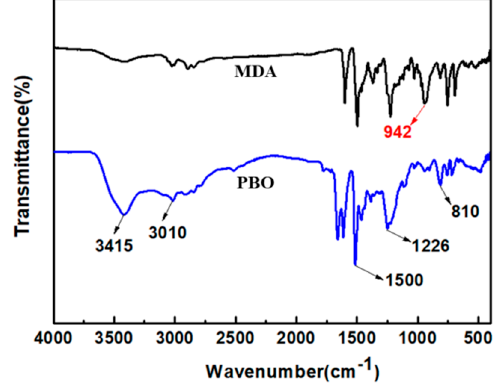
Figure 2. FT-IR spectra of MDA monomer and PBO aerogels.